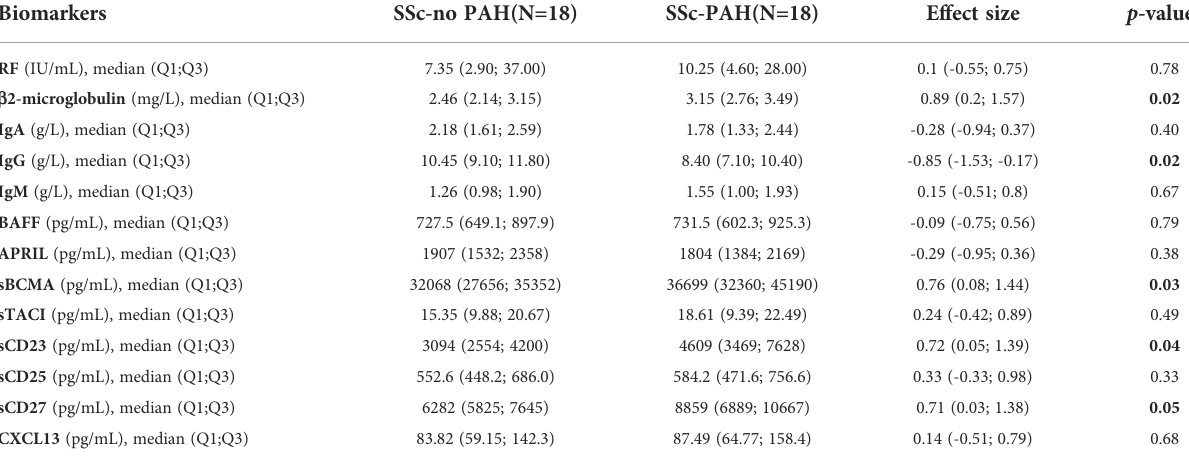
TABLE 5 Serum levels of soluble markers of B cell activation in SSc patients with and without PAH (validation cohort). Biomarkers SSc-no PAH(N=18) SSc-PAH(N=18) Effect